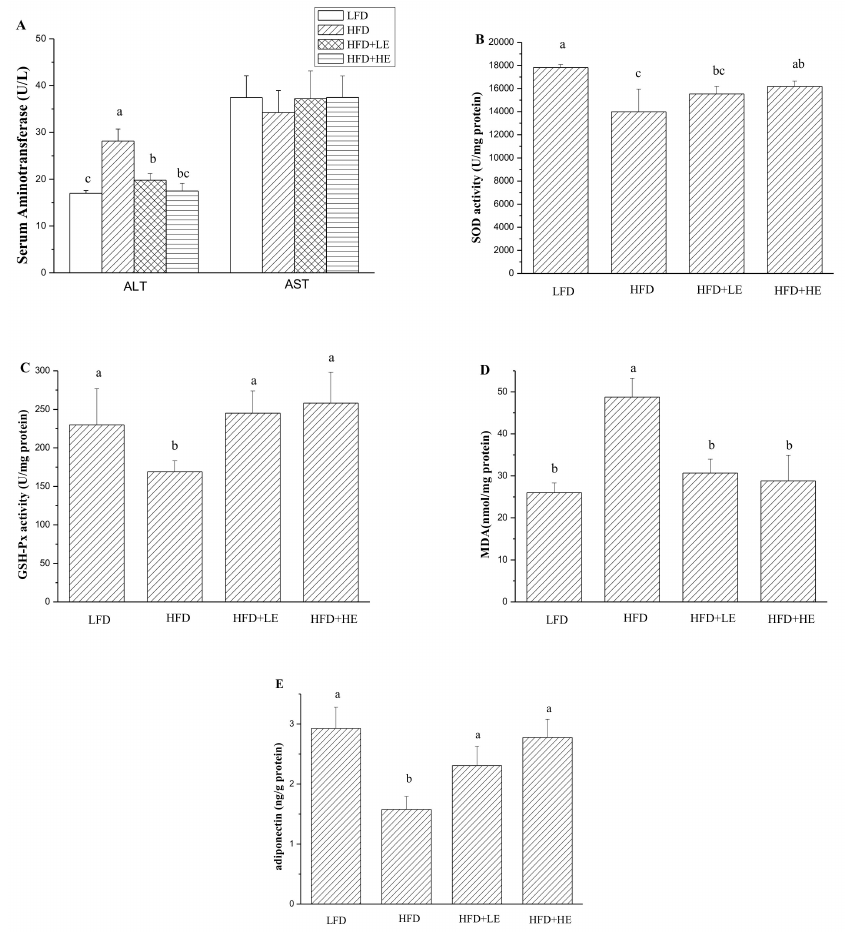
Figure 3. Effects of SCPE on serum ALT and AST activities ( A ), hepatic SOD activity ( B ), GSH-Px ( C ), MDA ( D ) and adiponectin ( E ) content. Different lower-case letters correspond to significant differences at p <